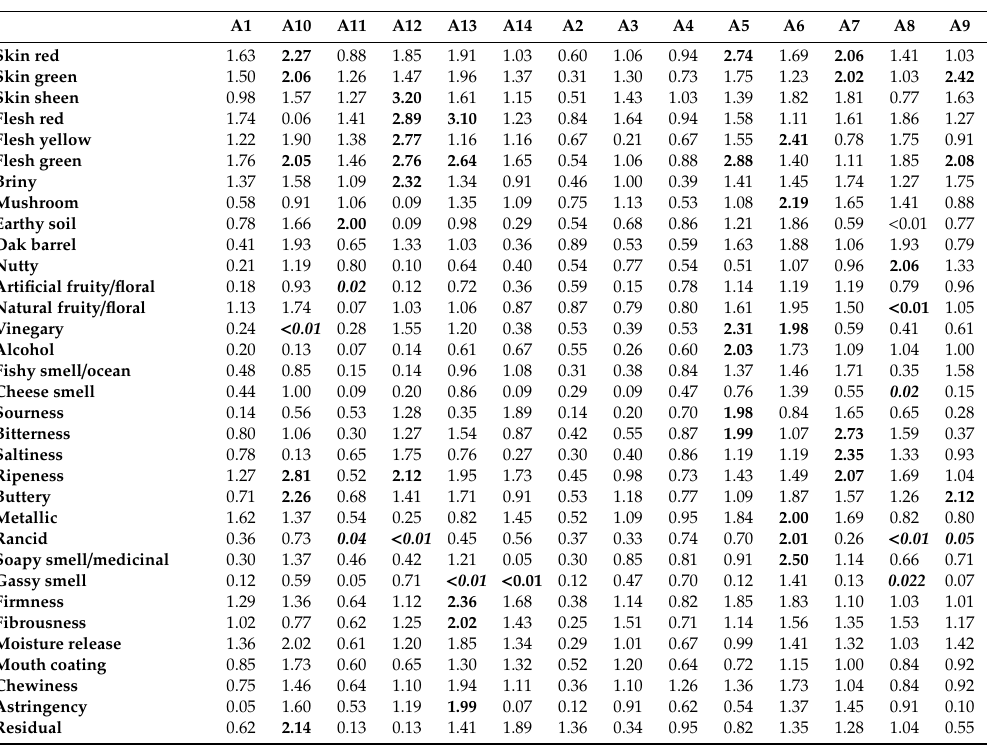
Table 3. Panelist repeatability as assessed by the ANOVA residuals according to descriptors.